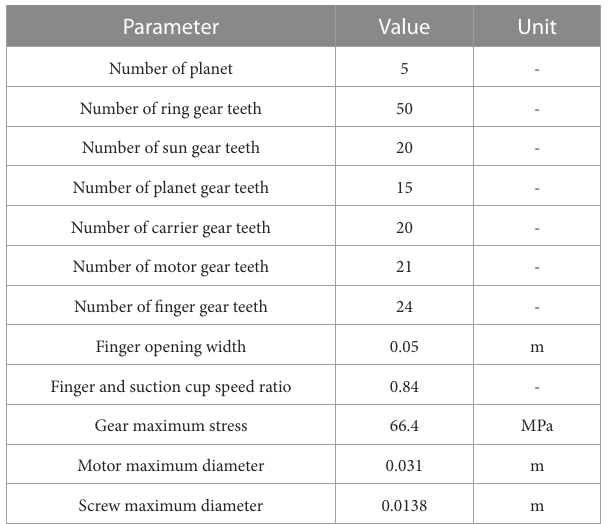
TABLE1 Prototypespecifications.